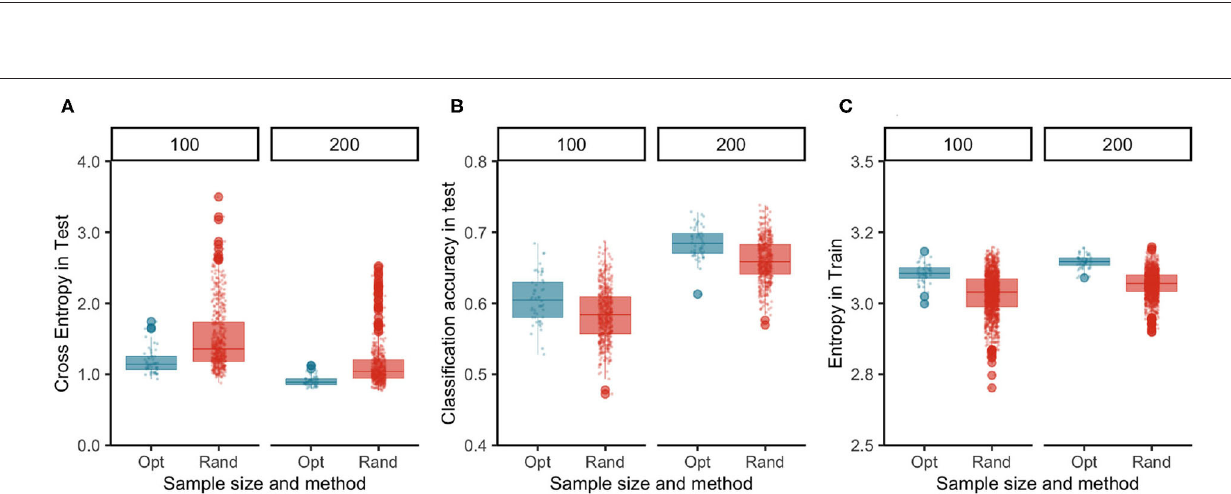
FIGURE 3 | Optimally designed multi-environmental GS experiments can boost prediction accuracies. In the first row, the CDmin values of the optimal samples show that the CDmin values are maximized for the intermediate amount of replication between the experiments. The second and third rows of figure show the attained accuracy for optimal samples and random samples for plant height and stripe rust.